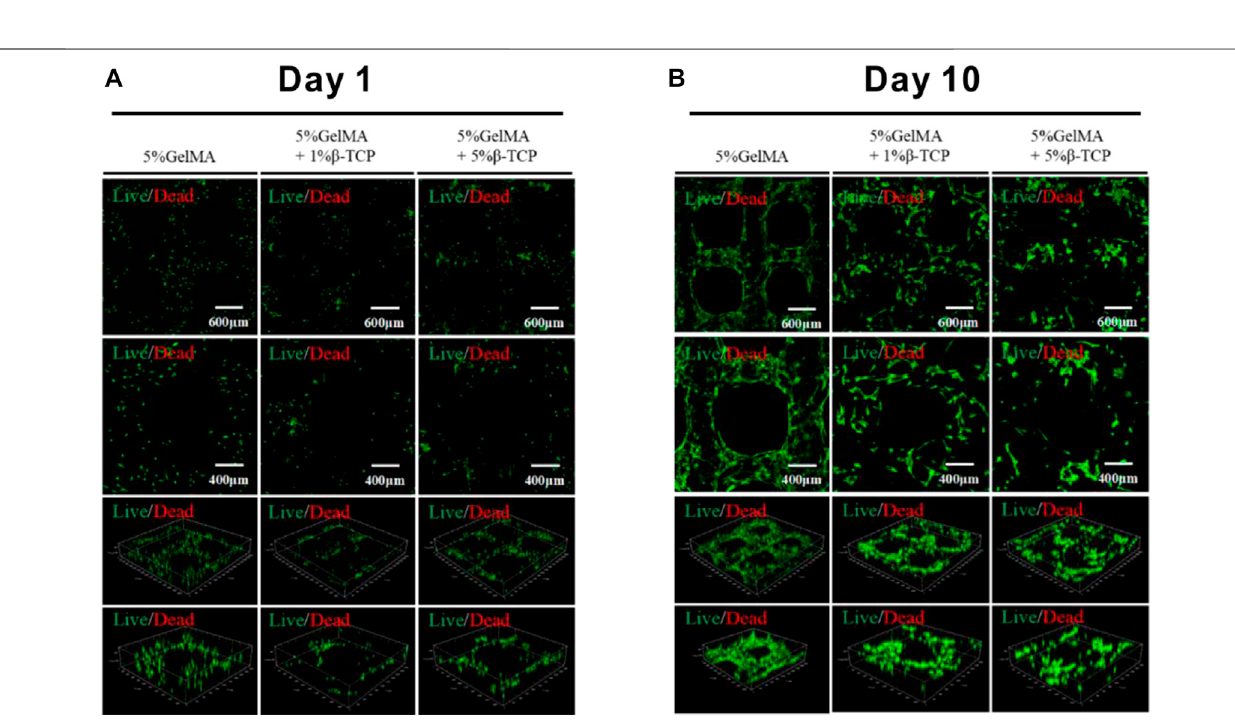
Frontiers in Bioengineering and Biotechnology |